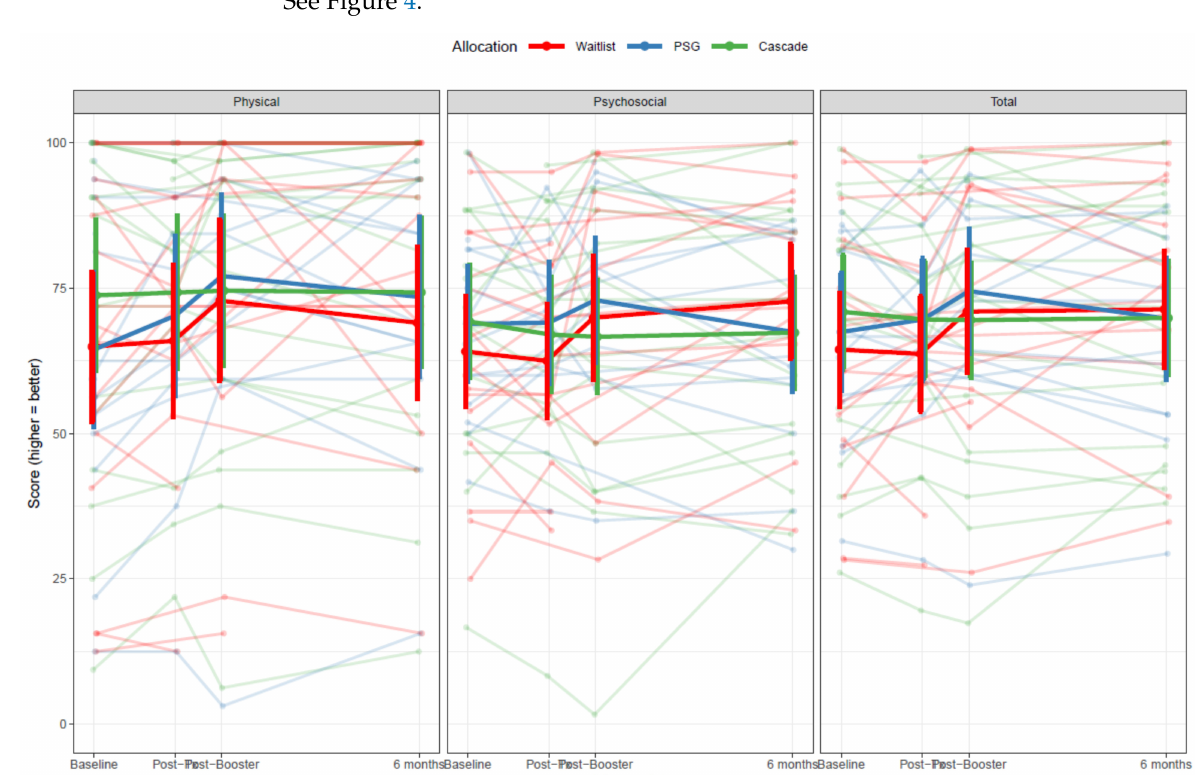
Figure 4. The PedsQL parent-proxy report of health-related quality of life scores for their child who had completed cancer treatment, compared across Cascade, peer-support and waitlisted groups across each time-point The PedsQL parent proxy report contains 21–23 questions about the child’s quality of life across four domains: physical functioning (8 questions), emotional functioning (5 questions), social functioning (5 questions) and school functioning (3–5 questions). The questions are dependent on the child’s age, in categories of 2–4 years, 5–7 years, 8–12 years and 13–18 years. The major difference is that the (pre)school functioning domain contains only three questions for the 2–4 year age group, and five for the older groups. The other differences between age groups are minor: for example, the 2–4 year age group contains a question about picking up toys where the older groups have a question about chores, and the 13–18 year age group asks about “getting along with other teenagers” whereas the corresponding question in the younger groups is about “getting along with other children”. The scoring system is the same across all age groups: original responses are given on a scale from 0 (never a problem) to 4 (almost always a problem) and are reverse-scored and linearly transformed such that 0 = 100 and 4 = 0, and combined to form subscale and summary scores by taking the average score (as long as at least 50 percent of questions are answered). Three summary scores are produced: physical health (including items from the physical functioning subscale), psychosocial health (emotional, social and school functioning subscales) and total (all items). These scores range between 0 and 100, with higher scores indicating better quality of life. Note that two responses in the school functioning subscale were missing and that on five occasions, parents appear to have answered the HRQL questions for 2–4 year olds, even though their children were aged over 4. The above graph shows the individual scores over time, as well as the average scores (with 95% CI) in each study arm in